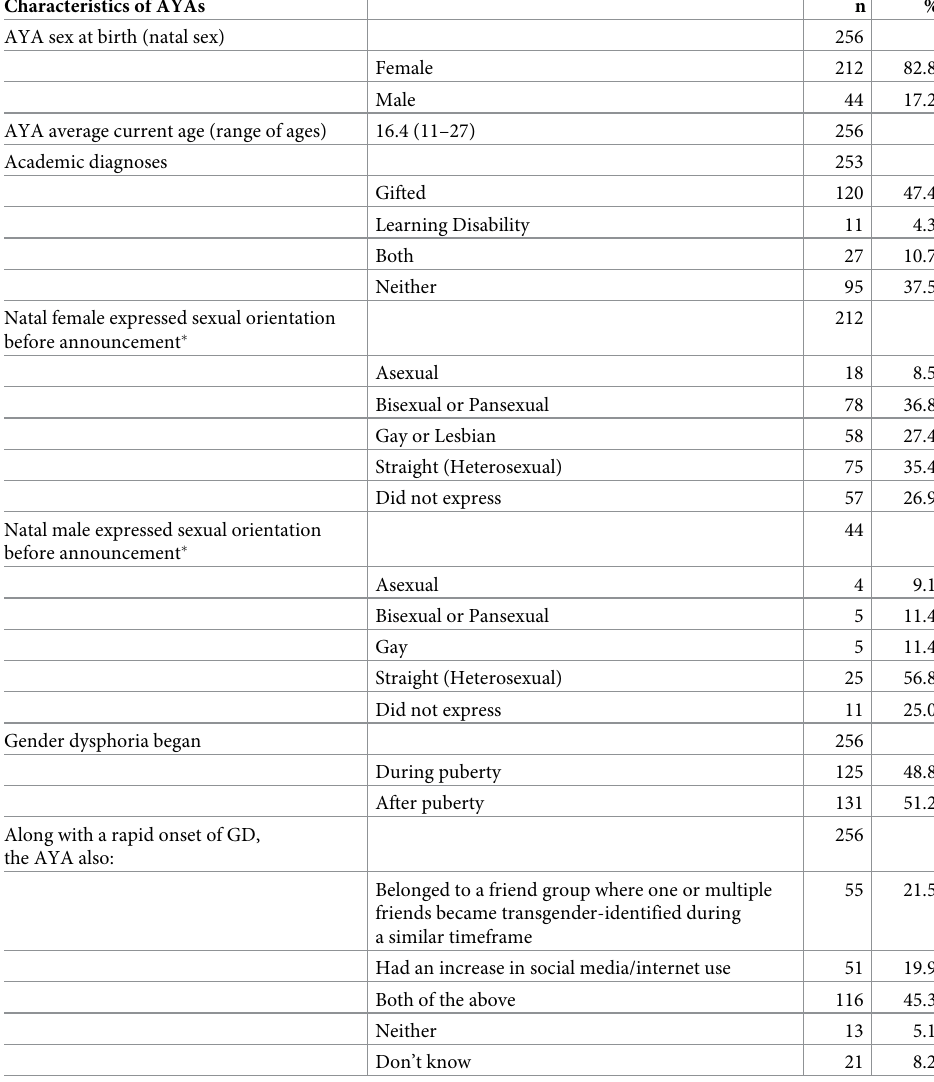
Table 2. Demographic and other baseline characteristics of AYAs. Characteristics of